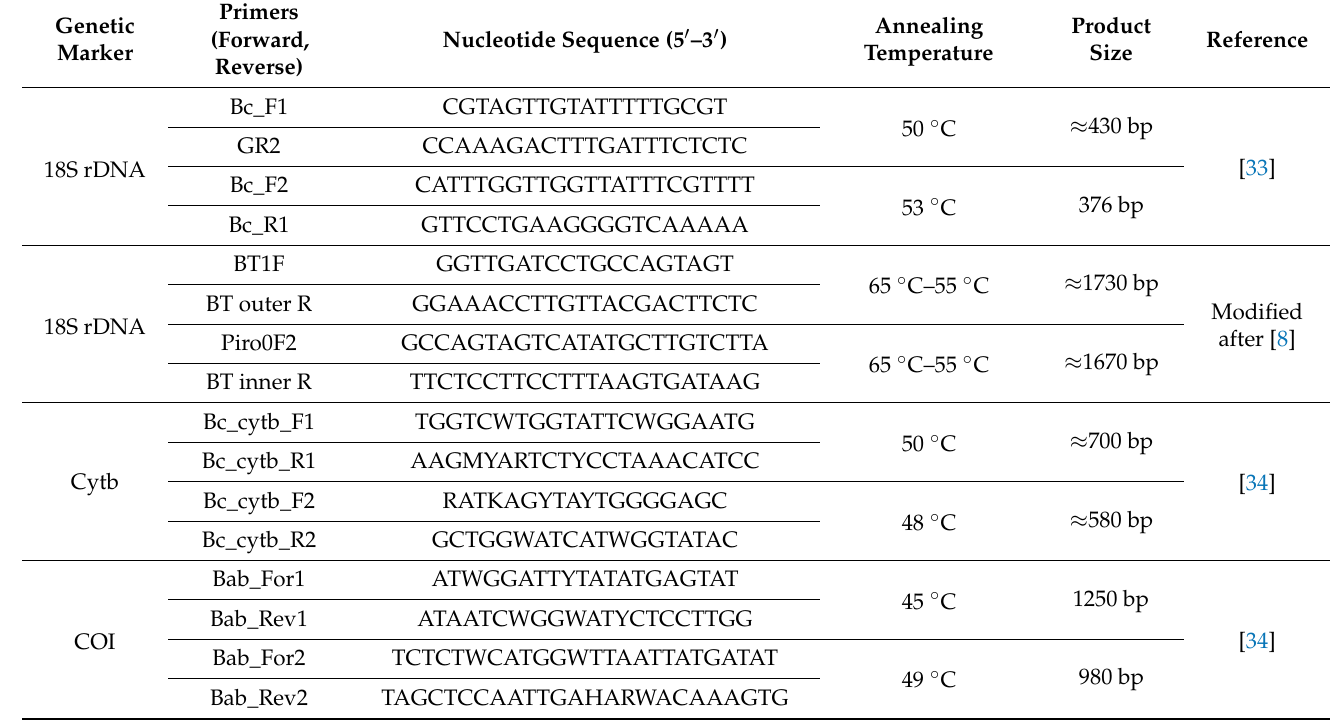
Table 1. Primer pairs, annealing temperatures, and expected length of